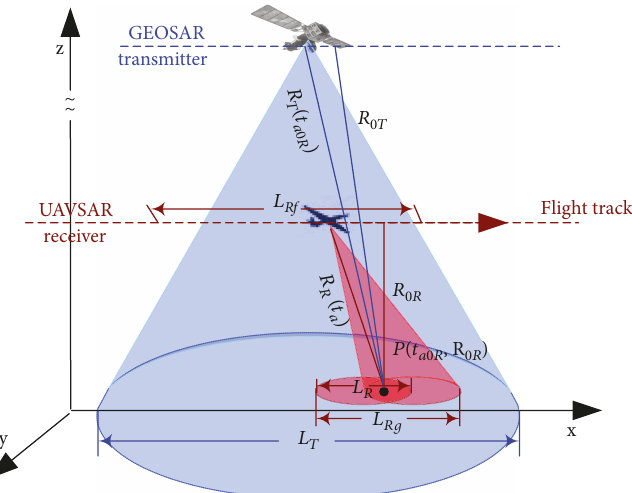
Figure 1: Geometrical con fi guration of GEO-UAV BiSAR (UAVSAR works in the TOPS